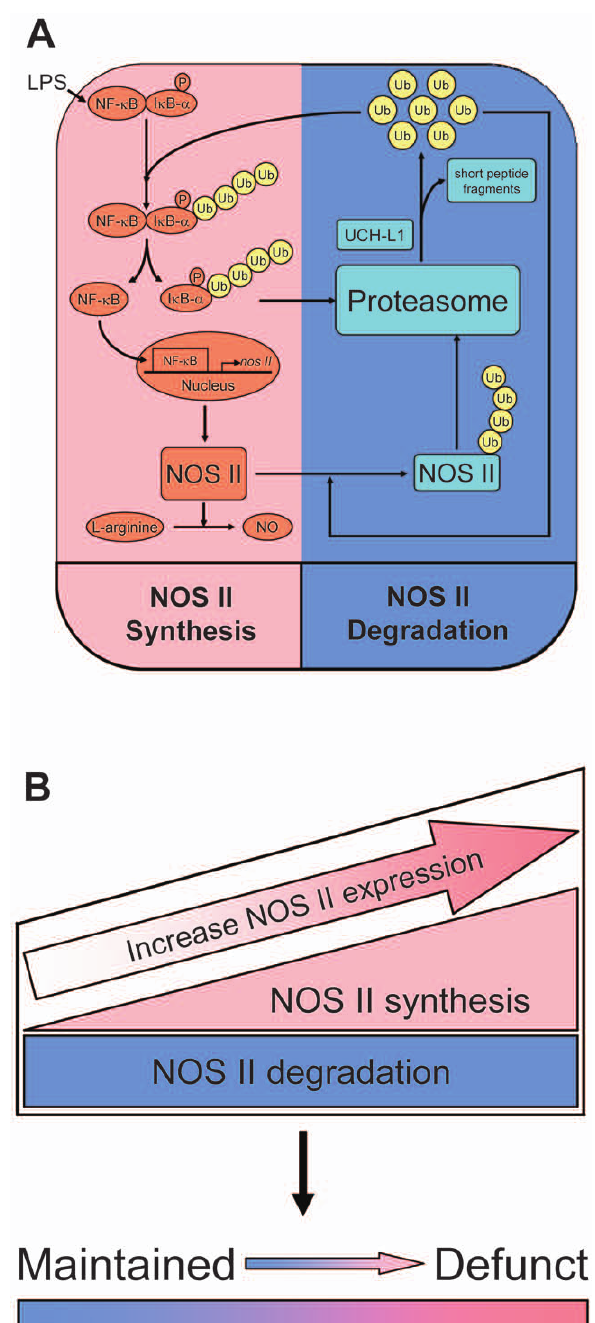
Figure 8. Schematic illustration of a double-edge sword role for the UPS in brain stem cardiovascular regulation during experimental brain death. A crucial determinant in the tug-of-war between maintained and defunct brain stem circulatory control resides in the balance between degradation and synthesis (via NF- k B activation) of NOS II, both processes of which require augmented ubiquitination, enhanced proteasome activities and de-ubiquitination in